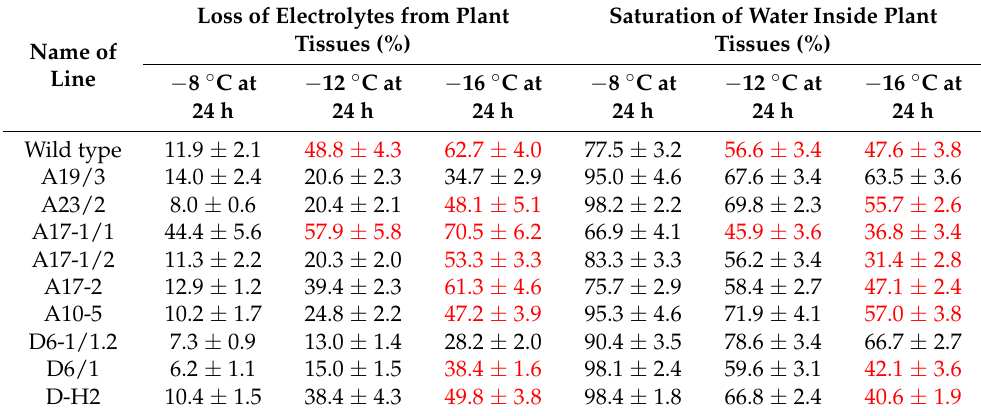
Table 2. Loss of electrolytes (%) from leaves of hardened transgenic plants and non-transgenic plants on the first day after 24 h exposure at negative temperatures and water content (%) in the same plants a week after exposure at negative temperatures relative to plants without